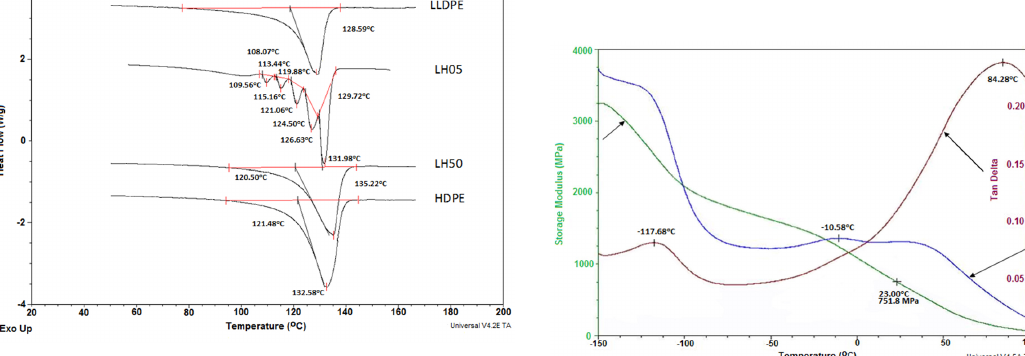
Figure 7. Comparison of the fractioning of LH05, LH50, LLDPE and HDPE.